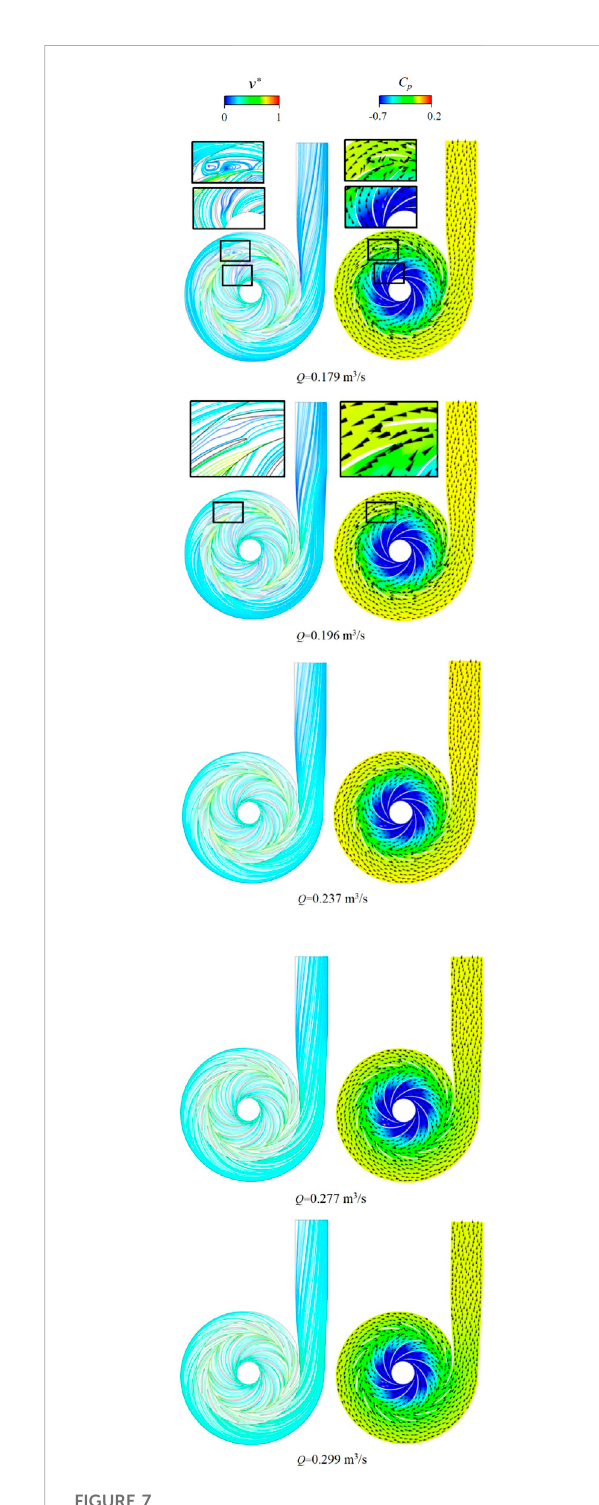
FIGURE 7 Streamline and pressure velocity distribution of pump